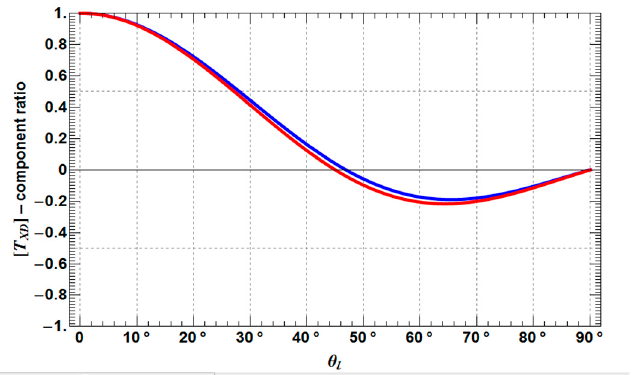
Figure 19. Sensitivity of ( T XD22 − T XD33 )/( T XD22 + T XD33 ) with roughness angle θ 1 (blue) ( ε s = 20, ε t = 10, ω l = 30 ◦ , φ = 0 ◦ ) and comparison with sinc (4 θ 1 ) (red) . Remote Sens. 2016 , 8 , 818